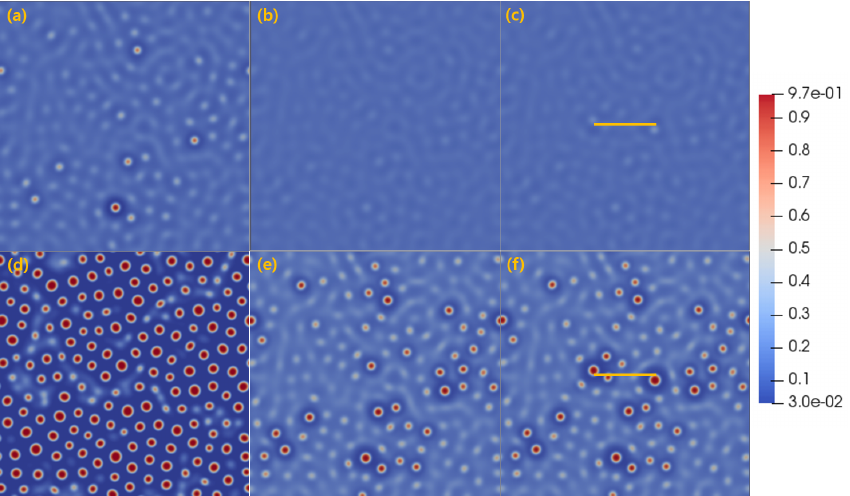
Figure 7. Microstructures of the Fe-21Cr system ( a ) without elasticity at t = 50, ( b ) with inhomogeneous elasticity without dislocation at t = 50, ( c ) with inhomogeneous elasticity and dislocation at t = 50, ( d ) without elasticity at t = 70, ( e ) with inhomogeneous elasticity without dislocation at t = 70, and ( f ) with inhomogeneous elasticity and dislocation at t = 70. The system size was 256 × 256 µ m 2 . The microstructures were visualized by Cr composition.